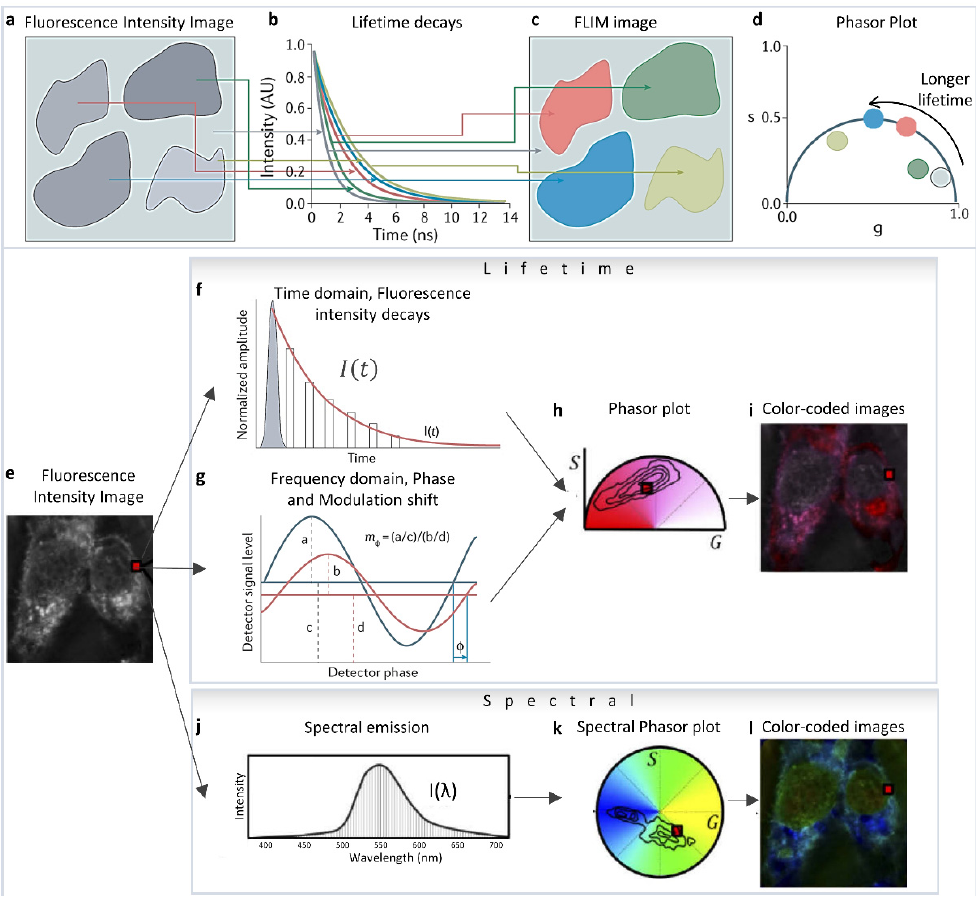
Figure 1. Phasor transformation. ( a ) Fluorescence lifetime imaging microscopy (FLIM) measures the fluorescence lifetime decays in different parts of the image ( b ), and color-codes areas ( c ) according to their decay times ( b ) or their phasor clusters ( d ). The resulting phasor plot ( d ) represents